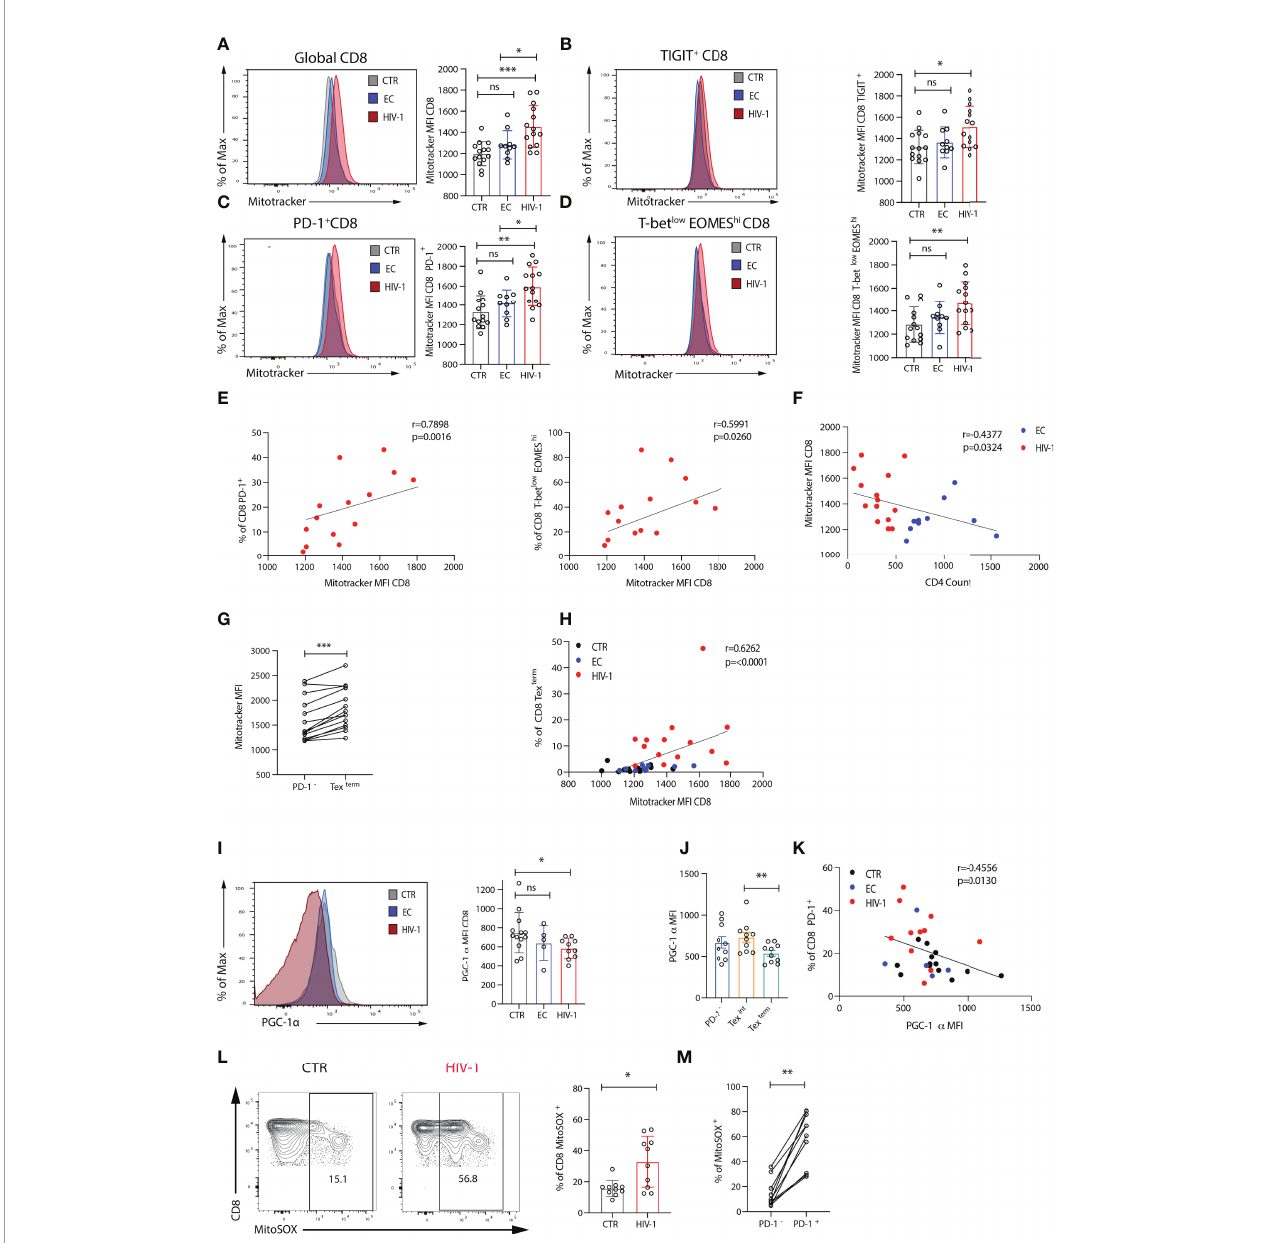
FIGURE 4 | Exhausted CD8 T cells from viraemic HIV-1 positive individuals are associated with mitochondrial impairment. (A) Comparison of mitochondria mass in global, (B) TIGIT + , (C) PD-1 + , (D) T-bet low EOMES hi CD8 T cells from n = 14 HIV-1 negative controls (CTR) n = 10 elite controllers (ECs), n = 14 viraemic HIV-1 positive individuals by Mitotracker Green staining, representative histograms, and summary data. (E) Correlation between percentage of PD-1 + and T-bet low EOMES hi CD8 T cells and Mitotracker green (Mitotrtacker) MFI in CD8 T cells from n = 14 viraemic HIV-1 positive donors. (F) Correlation between Mitotracker MFI in CD8 T cells and CD4 count in EC and HIV-1 positive donors. (G) Comparison of Mitotracker MFI in PD-1 - and terminally exhausted (Tex term ) (T-bet low EOMES hi PD- 1 + TIGIT + CD38 + ) CD8 T cells in paired samples from viraemic HIV-1 positive patients. (H) Correlation between percentage of terminally exhausted (Tex term ) and Mitotracker MFI in CD8 T cells from the study groups. (I) A representative histogram of PGC-1 a expression in CD8 T cells from an HIV-1 negative control (CTR), an elite controller (EC), and a viraemic HIV-1 positive donor (HIV-1), and summary data from n = 12 HIV-1 negative controls (CTR) n = 5 elite controllers (ECs), n = 10 viraemic HIV-1 positive donors (HIV-1). (J) Comparison of PGC-1 a expression in PD-1 - , intermediate (Tex int ) and terminally exhausted (Tex term ) CD8 T cells in paired samples from viraemic HIV-1 positive patients. (K) Correlation between percentage of PD-1 + CD8 T cells and PGC-1 a expression in CD8 T cells from the study group. (L) A representative histogram of the MitoSOX staining in CD8 T cells from an HIV-1 negative control (CTR), and a viraemic HIV-1 positive donor (HIV-1), and summary data from n = 10 HIV-1 seronegative controls (CTR) and n = 10 viraemic HIV-1 positive donors (HIV-1). (M) Comparison of percentage of MitoSOX + cells in PD-1 - and PD-1 + CD8 T cells in paired samples from viraemic HIV-1 positive patients. The non-parametric Spearman test was used for correlation analysis. Bars show mean ± SD. **p < 0.01, ***p < 0.001. ns, non-signi fi cant, *p <